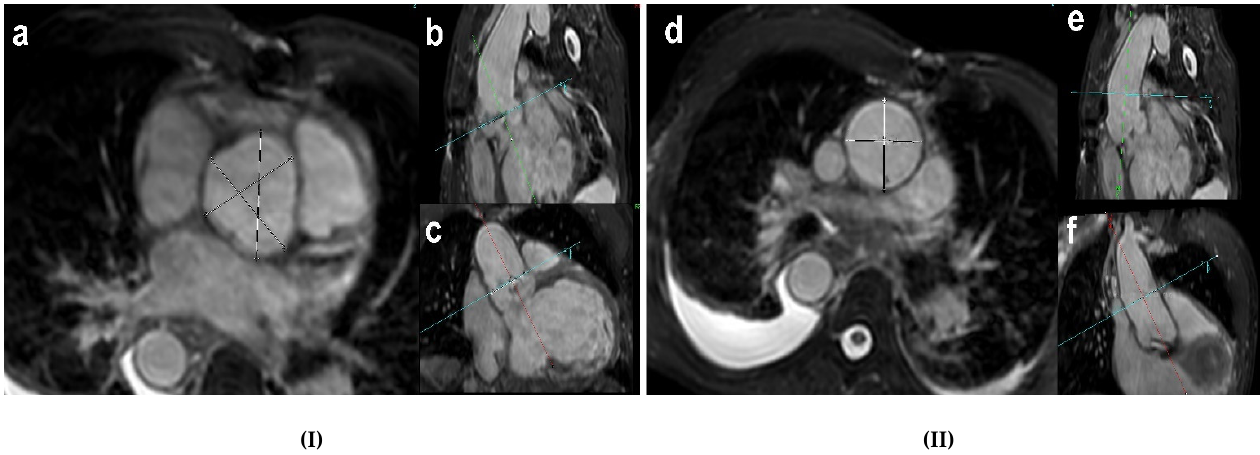
Figure 1. ( I ) ( a ). Transverse plane image at the level of SoV, end-diastolic capture, showing the measurement lines from cusp to cusp (black lines). ( b ). An oblique longitudinal LVOT cine image. ( c ). An oblique frontal LVOT cine image. ( II ) ( d ). Transverse plane image of AAo at the level of the left pulmonary artery, end-diastolic capture, showing the measurement lines (black lines). ( e ). An oblique longitudinal LVOT cine image. ( f ). An oblique frontal LVOT cine image. Green lines and red lines are parallel to blood flow and perpendicular to the blue line, which represents the equivalent level of measurements. AAo, ascending aorta; LVOT, left ventricular outflow tract; SoV, sinus of Valsalva.